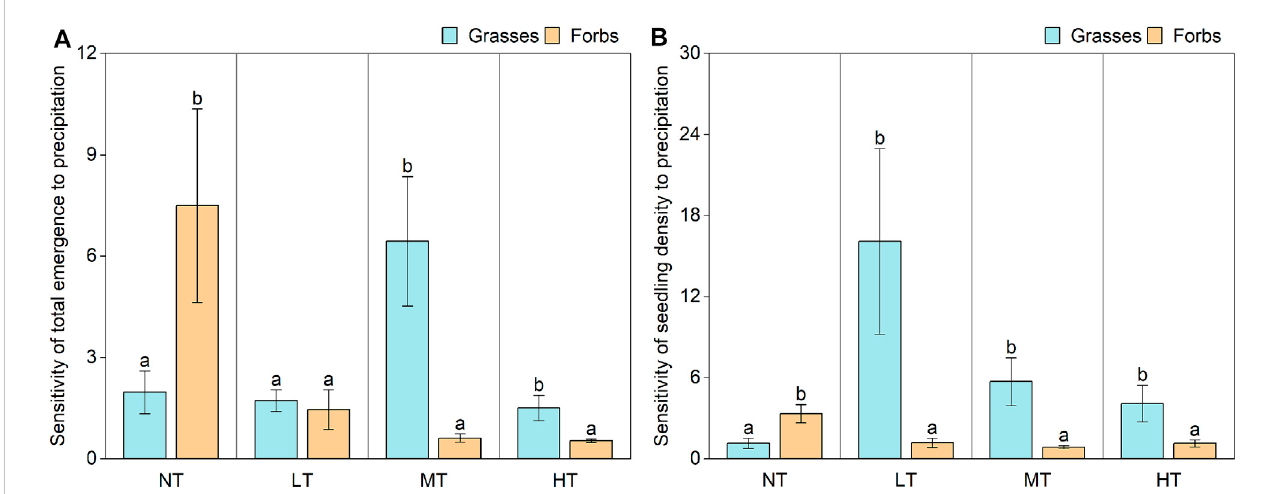
FIGURE 6 Sensitivities of total seedling emergence and seedling density of the grasses and forbs to precipitation variation under different trampling treatments. (A) Sensitivity of total seedling emergence to precipitation variation; (B) Sensitivity of seedling density to precipitation variation. Different letters indicate signi fi cant difference in sensitivity between the grasses and forbs in same groups at 0.05